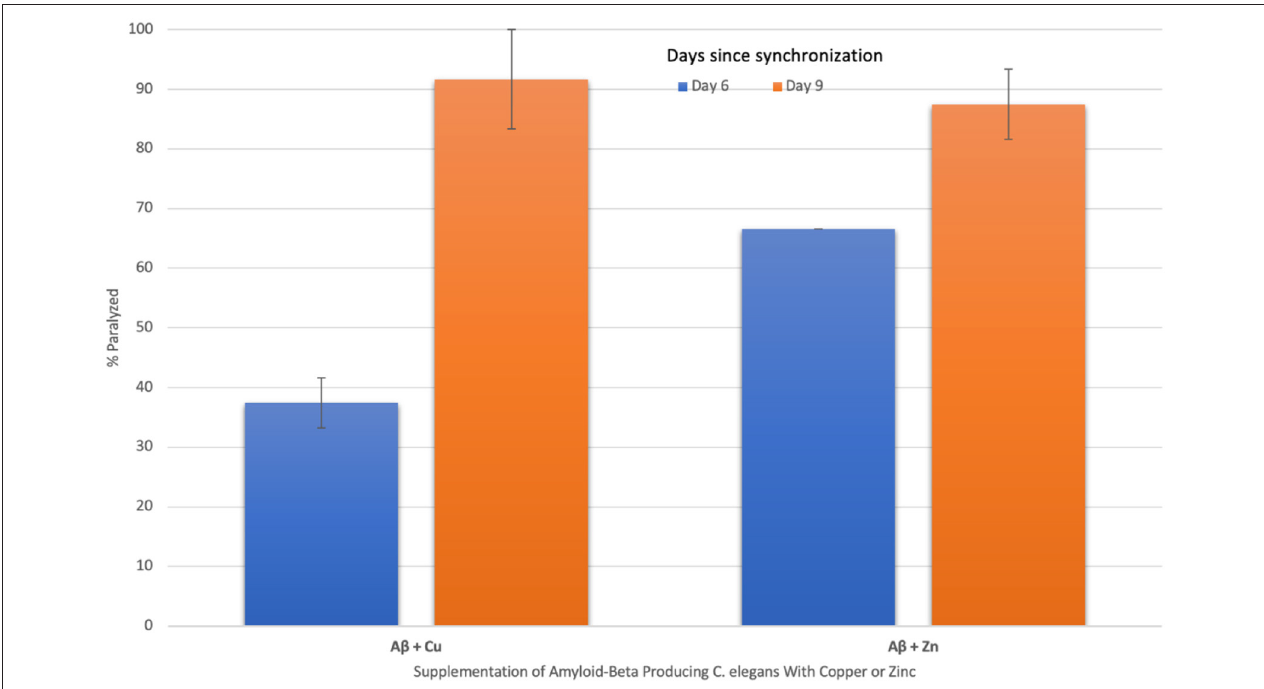
FIGURE 3 | The effect of supplementing amyloid-beta producing C. elegans with copper and zinc on percent paralyzed over time. When amyloid-beta producing C. elegans were supplemented with copper, a statistically significant ( p = 0.014) increase in % paralyzed occurred from day 6 (37 ± 4) to day 9 (92 ± 8). When supplemented with zinc, a statistically significant ( p = 0.019) increase in % paralyzed also occurred from day 6 (67 ± 0) to day 9 (87 ± 4). The change in percent paralyzed is larger for the copper-supplemented group compared to the zinc-supplemented group. Values are mean ± SEM and are representative of 2 experiments where 20 C. elegans were analyzed at each time